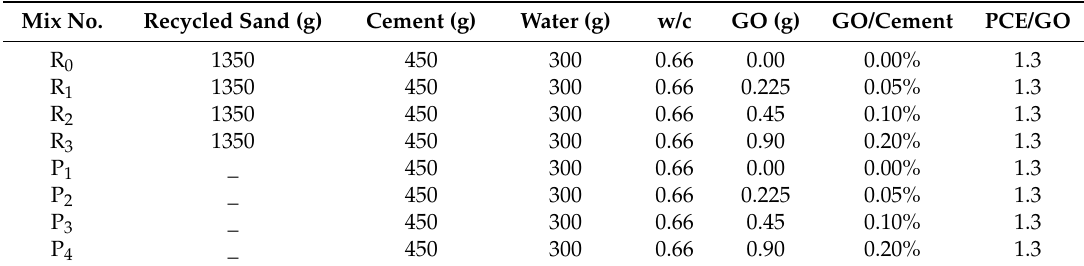
Table 3. Mix proportions of paste and recycled fine aggregate (RFA)